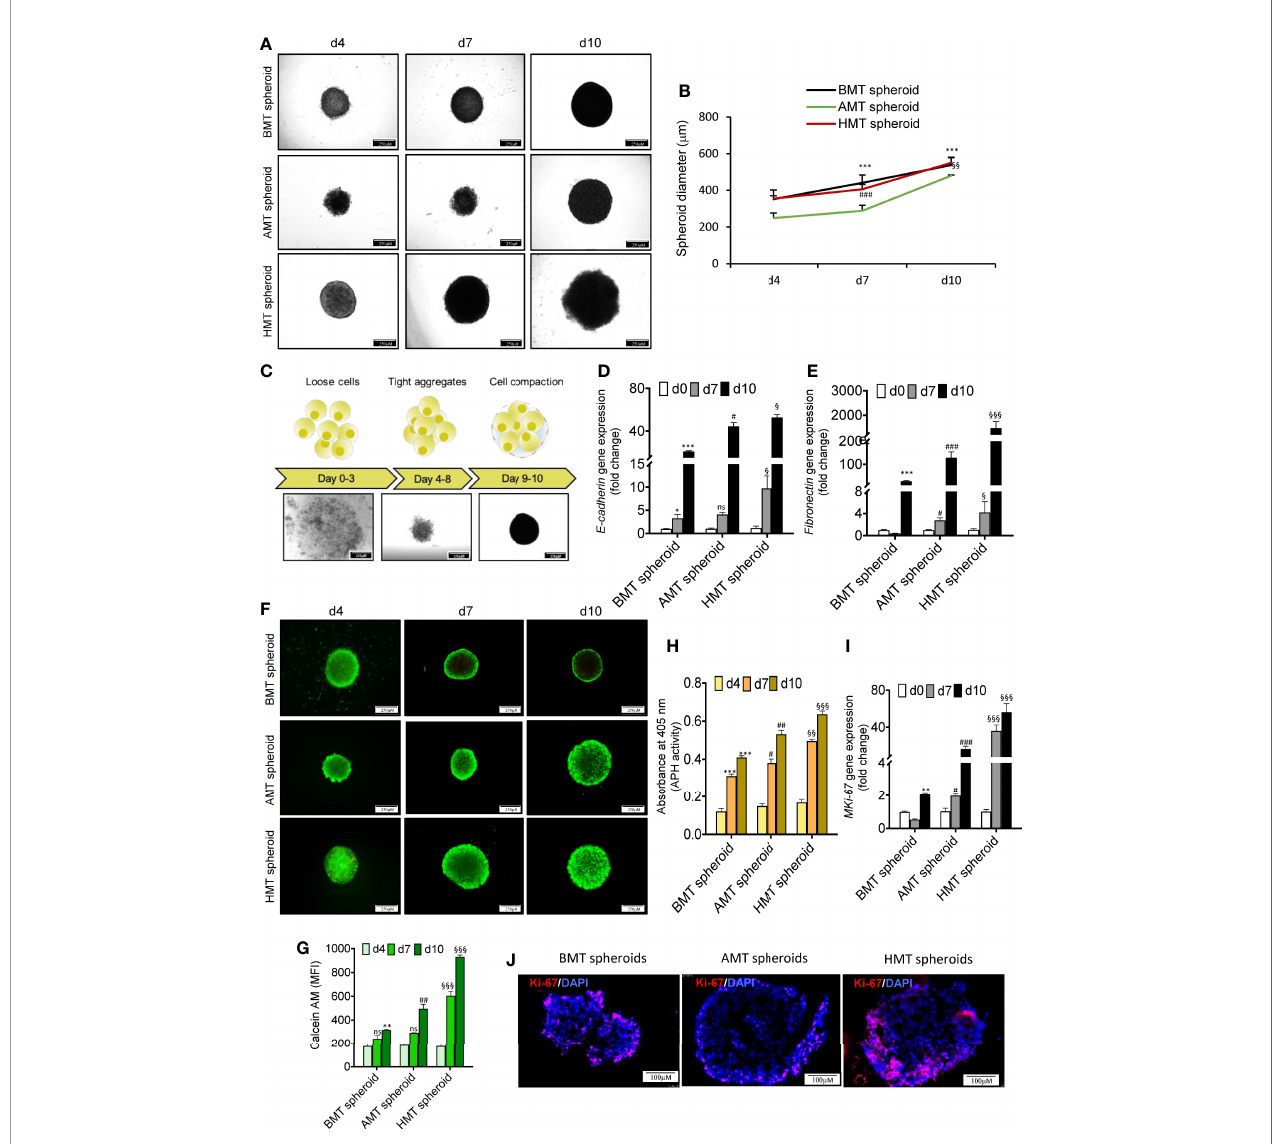
FIGURE 2 | Phenotypic characterization of multicellular 3D spheroid ’ s morphology, viability, and cell proliferation. (A) Microscopic images of multicellular 3D spheroids composed of BEAS-2B, MRC-5, and THP-1 (BMT spheroid); A549, MRC-5, and THP-1 (AMT spheroid); and NCI-H460, MRC-5, and THP-1 (HMT spheroid) on day 4, day 7, and day 10. (B) Measurement of spheroid ’ s diameter on day 4, day 7, and day 10. (C) Schematic diagram (upper panel) and microscopic images (lower panel) of spheroid development at different time points displaying initial loose association of cells (days 0-3) followed by tight aggregates (days 4-8) leading to compact spheroid formation (day 9onwards). (D, E) RT-qPCR analysis of E-cadherin (D) and fi bronectin (E) mRNA levels in BMT, AMT, and HMT spheroids on day 0, day 7, and day 10. (F, G) Calcein-AM and propidium iodide (PI) staining (F) , and the quanti fi cation of Calcein-AM-stained live cells (G) in BMT, AMT, and HMT spheroids on day 4, day 7, and day 10(n=3). (H) Determination of acid phosphatase(APH) activity in developed spheroids(n=3). (I) RT-qPCR analysis of cell proliferation marker MKi67 in BMT, AMT, and HMT spheroids on day 4, day 7, and day 10(n=3). (J) Immuno fl uorescence images of Ki67 protein in day 10 spheroids section. DAPI was used for nuclei counterstaining. GAPDH is a loading control for RT-qPCR studies. Fold change for E-cadherin , fi bronectin , and MKi- 67 gene expression was calculated keeping the spheroid cell cocktail (BEAS-2B/MRC-5/THP-1, A549/MRC-5/THP-1, and NCI-H460/MRC-5/THP-1) at day 0 as control. All experiments were performed in triplicate (n=3). Data represented as mean ± S.D. 2D vs BMT over time *p< 0.05, **p< 0.01, ***p< 0.001; BMT vs AMT over time # p< 0.05, ## p< 0.01, ### p< 0.001; BMT vs HMT over time § p< 0.05, §§ p< 0.01, §§§ p< 0.001; ns, non-signi fi